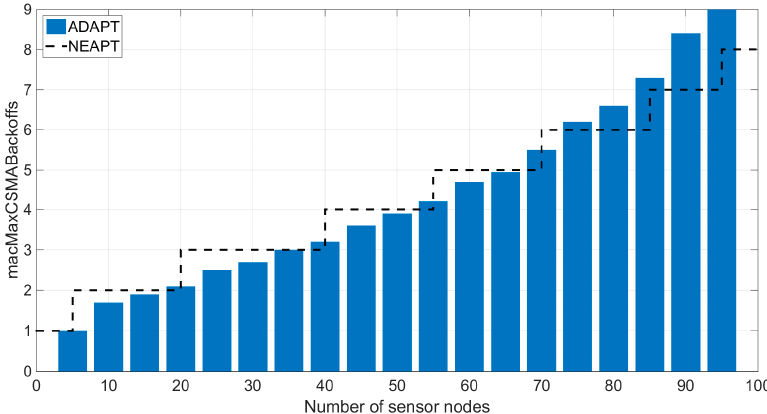
Figure 6. Optimal values of macMaxCSMABackoffs derived from the analytical model and simulation.